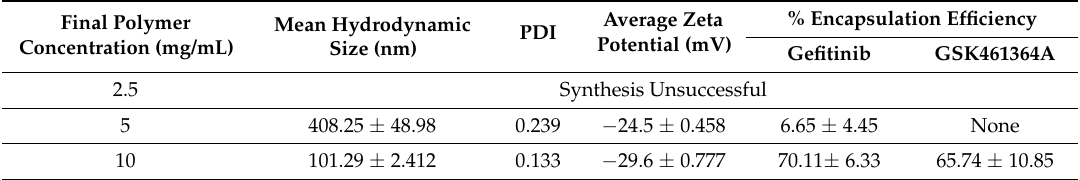
Table 2. Polymer concentration optimization for successful synthesis and encapsulation of gefitinib and GSK461364A in PLGA-PEG